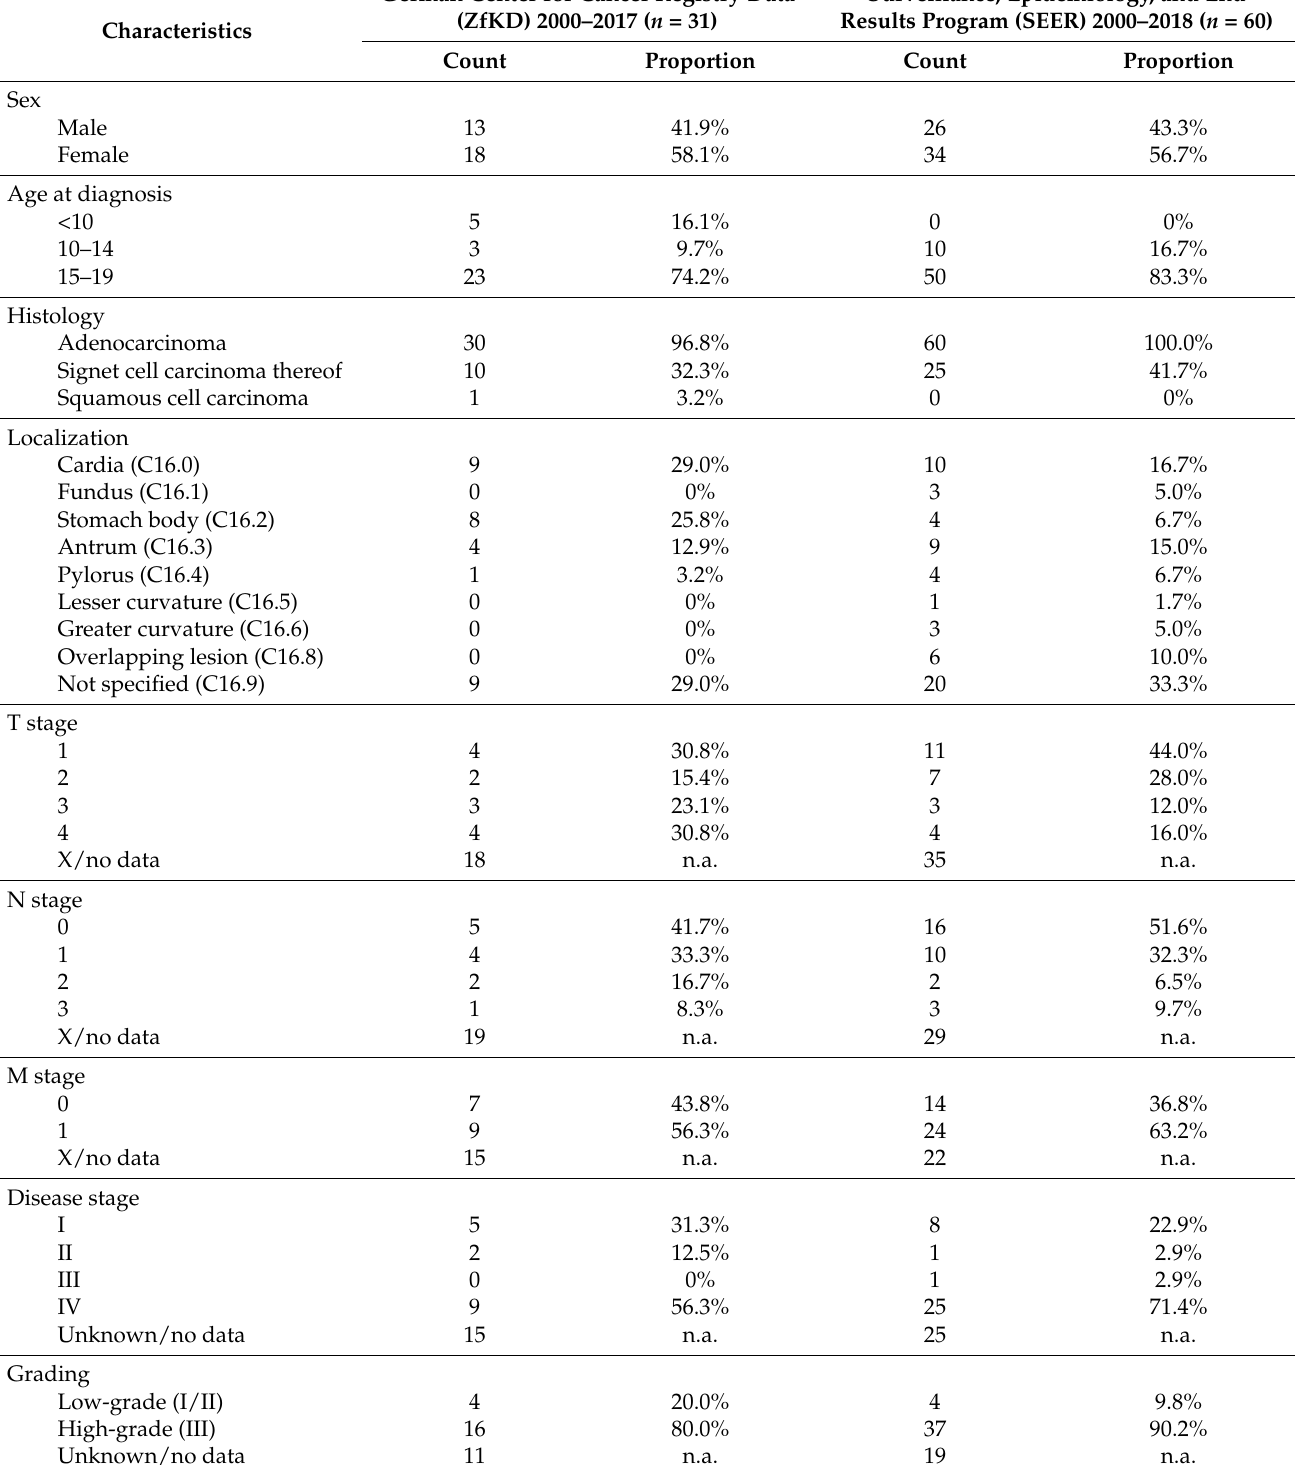
Table 1. Patient characteristics and clinical features of gastric carcinoma in patients aged 0–19 years registered at the German Center for Cancer Registry Data 2000–2017 and in the Surveillance, Epidemiology, and End Results Program 2000–2018. Proportions are calculated based on cases with recorded data. Abbreviation: n.a., not